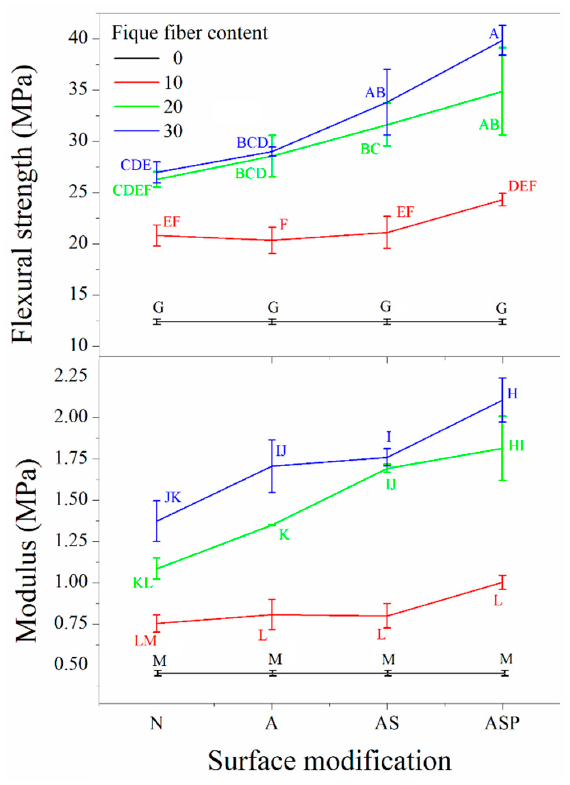
Figure 3. Principal effects on the maximum flexural strength and the flexural modulus (according to the statistical analysis the values that do not share a letter are significantly different).